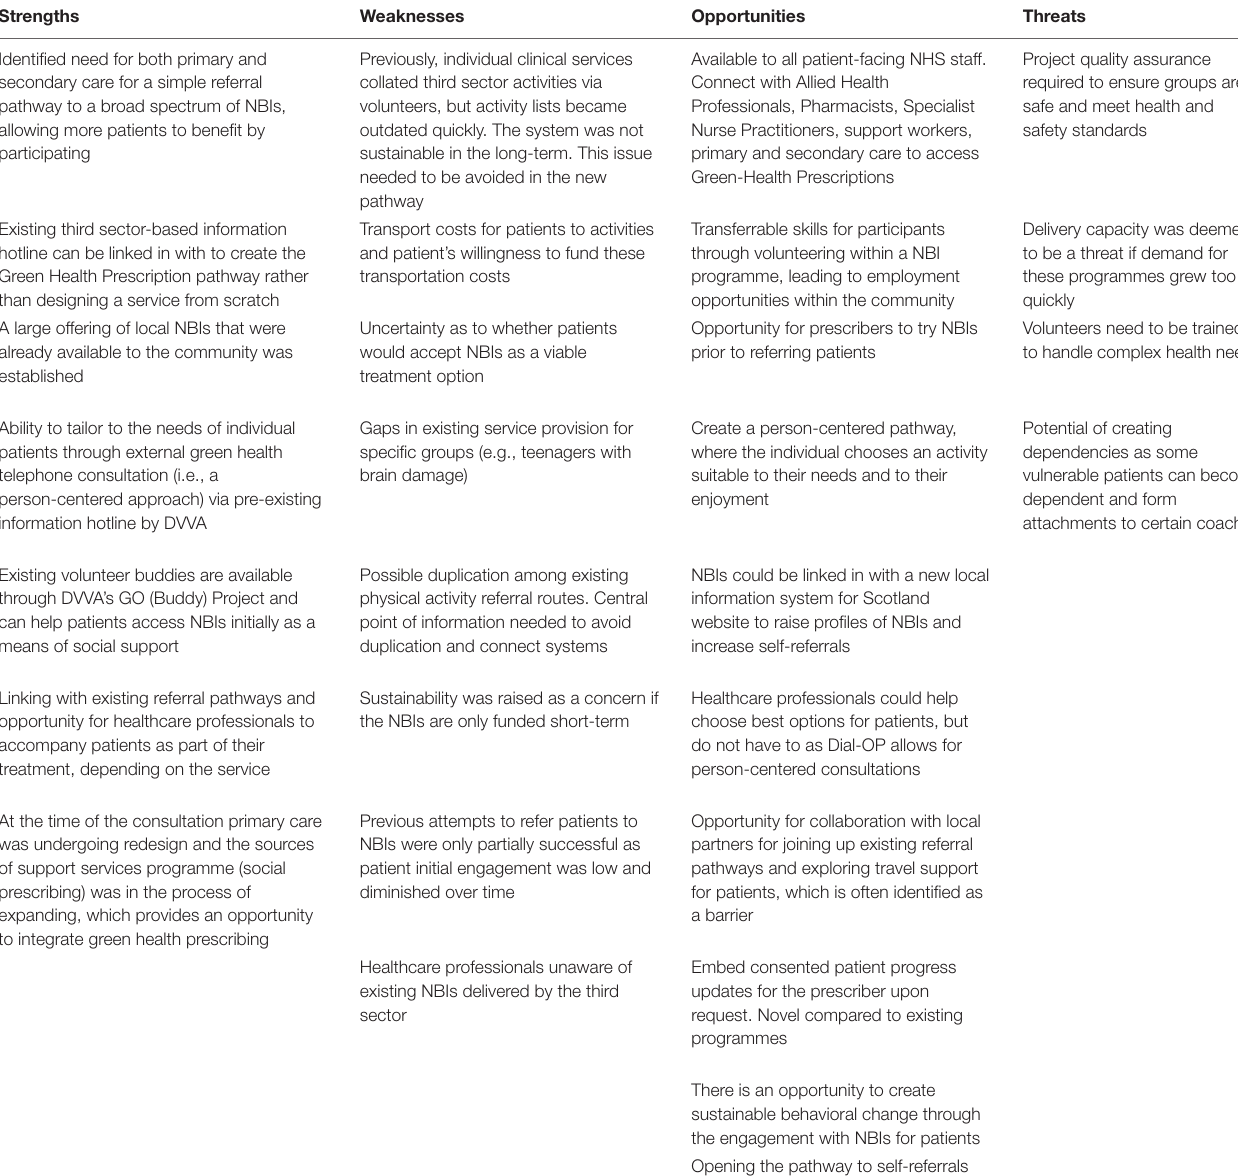
TABLE 1 | NHS stakeholder strengths, weaknesses, opportunities, and threats (SWOT) analysis.